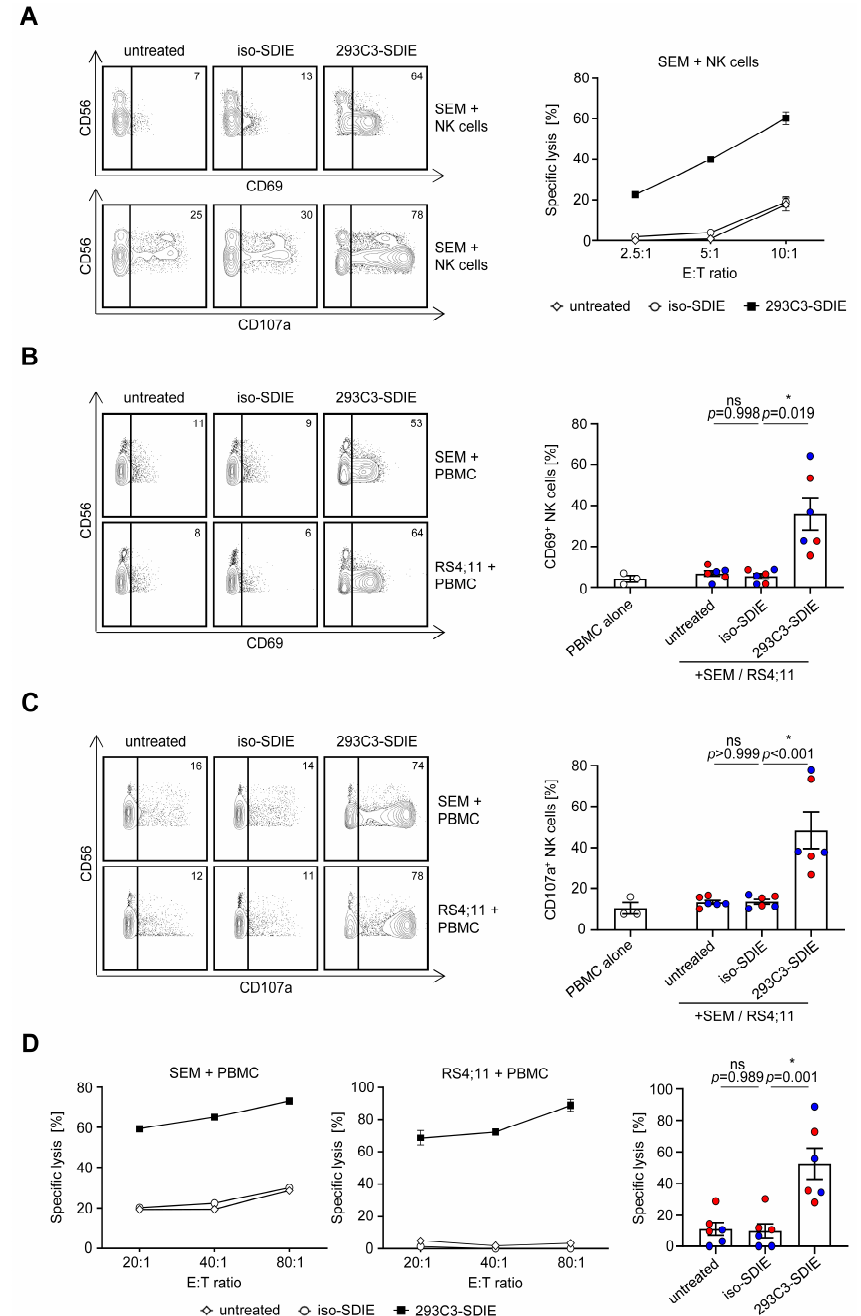
Figure 2. Induction of natural killer (NK) cell reactivity against CD133 + B-ALL cell lines. ( A – D ) The B-ALL cell lines SEM and RS4;11 were co-cultured with purified NK cells or PBMCs of healthy donors (effector to target (E:T) ratio of 2.5:1 or indicated E:T ratio) in the presence or absence of 293C3-SDIE and iso-SDIE (both 1 µg/mL) for 24 h (activation), 4 h (degranulation), or 2 h (Europium assay). To determine the NK cell activation and degranulation, the NK cells were identified as CD56 + CD3 − lymphocytes and stained with CD69 or CD107a with subsequent flow cytometric analysis. Target cell lysis of different B-ALL cell lines was analyzed by Europium assays. ( A ) Exemplary data of purified NK cells tested against the B-ALL cell line SEM. ( B , C ) Exemplary data from one PBMC donor (left panel) and pooled results of three PBMC donors tested with SEM (red) and RS4;11 (blue) (right panel) are shown (mean ± SEM). ( D ) Exemplary data from one PBMC donor (left panel) and pooled results of three PBMC donors tested with SEM (red) and RS4;11 (blue) at an E:T ratio of 80:1 (right panel) are shown (mean ± SEM). ns, not significant; * significant ( p < 0.05).